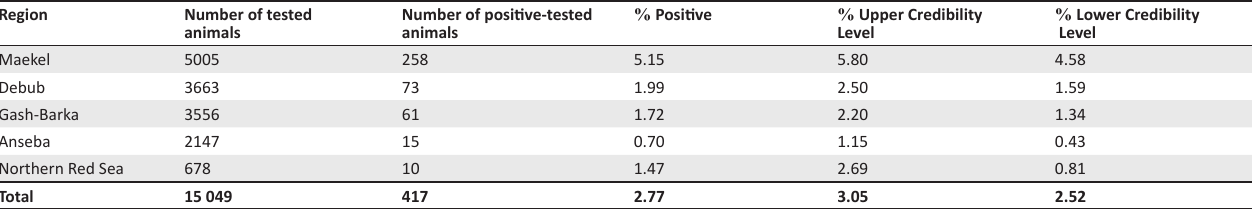
TABLE 1: Test results for brucellosis in dairy cattle at regional level in Eritrea, 2009. Region Number of tested